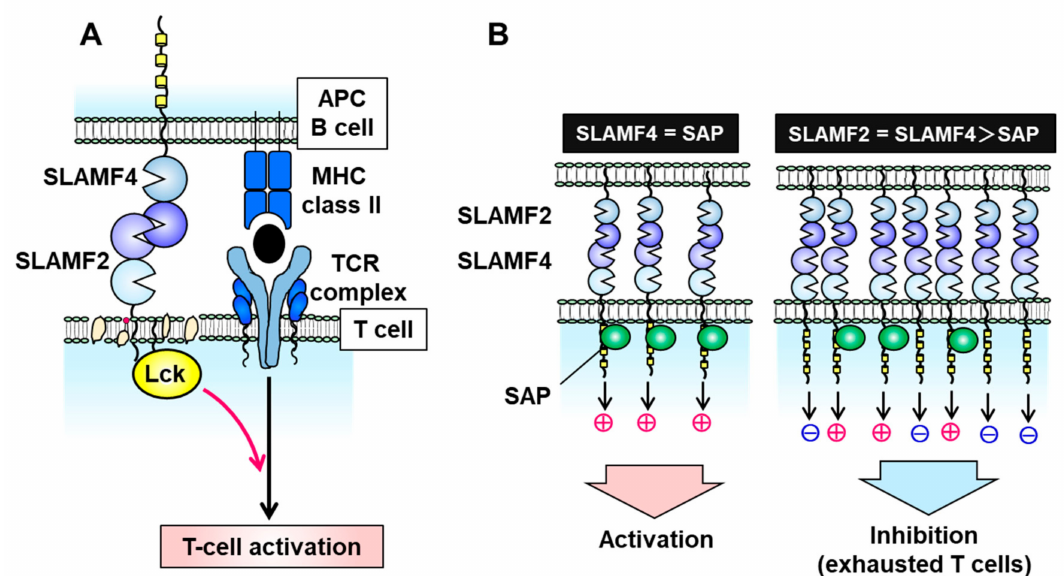
Figure 2. Signal transduction via the signaling lymphocytic activation molecule family receptor (SLAMF) 2–SLAMF4 interaction. ( A ) On T cells, SLAMF2 promotes T cell receptor (TCR) signaling and T cell activation by binding to SLAMF4 on antigen-presenting cells (APCs) and activating the tyrosine kinase Lck in T cell membrane lipid rafts. ( B ) The SLAMF2– SLAMF4 interaction facilitates natural killer (NK) or T cell activation in the presence of sufficient levels of the adaptor protein SAP but induces an inhibitory signal in the absence of